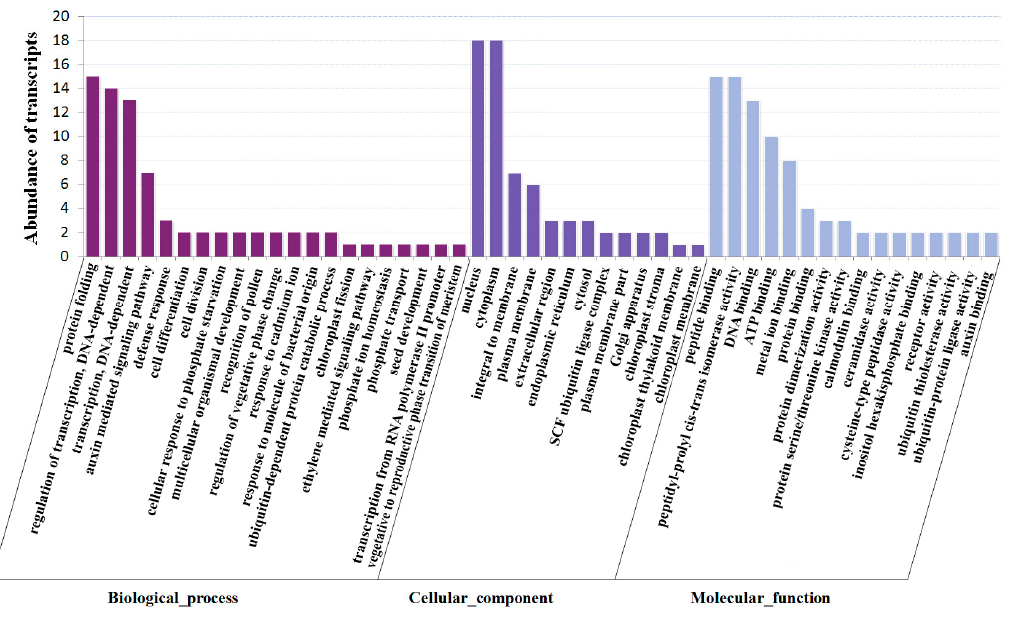
Figure 5. Gene ontology classification of target genes for differentially expressed known miRNAs between white fruit stage and mature fruit stage libraries in blueberry.